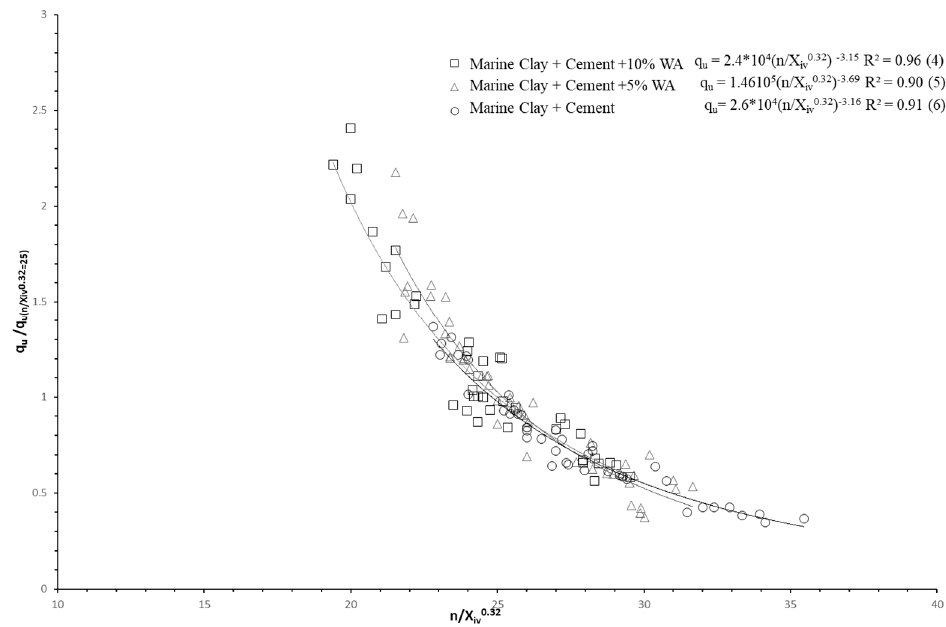
Figure 6. Normalization of unconfined compressive strength (q u ) (for the whole range of η / X iv0.32 ) with adjusted porosity / binder index for all blends considering cement only, cement + 5% wood-ash, and cement + 10% wood-ash.